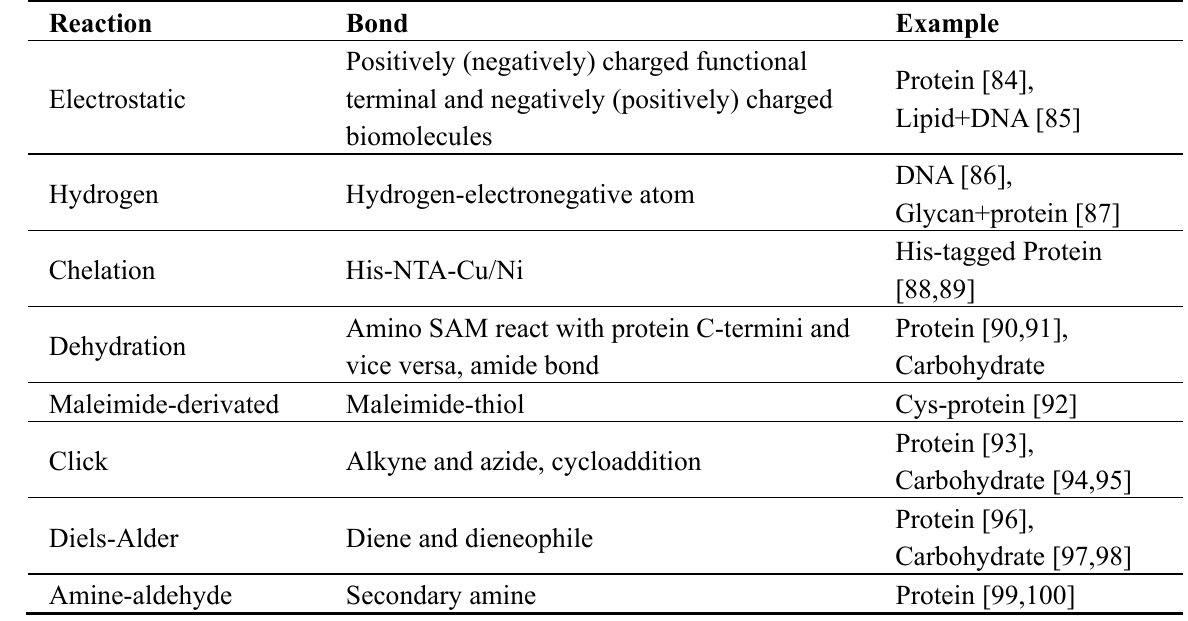
Table 3. Immobilization of biomolecules to biosensor